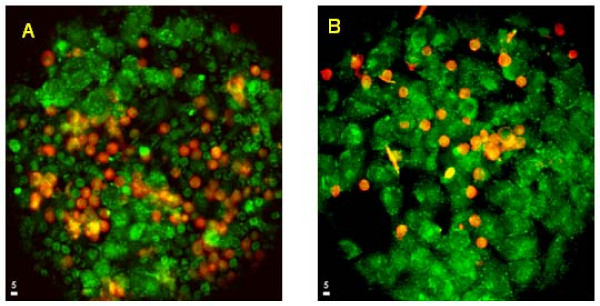
Tumor cells were grown on 40 mm coverslips to confluence and labeled with Calcein AM (green). Monocytes were labeled with DiI (C18; red), made to 1 × 106 cells/ml and continuously perfused across the tumor cells at 0.5 ml/min for 1 h. (Left) monocyte adherence to untreated A375 cells. (Right) monocyte (pre-treated with sFn) adherence to sFn pre-treated A375 cells. sFn pre-treatment of both effector and target cells inhibited monocyte adherence.